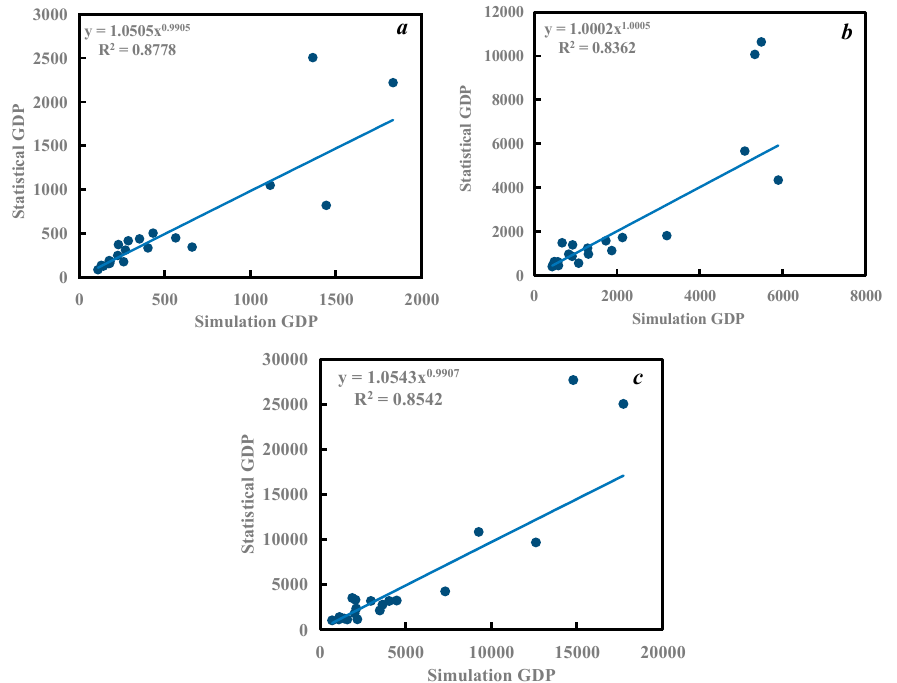
Figure 6. ( a - c )Correlation between simulated and statistical (GDP/100 million